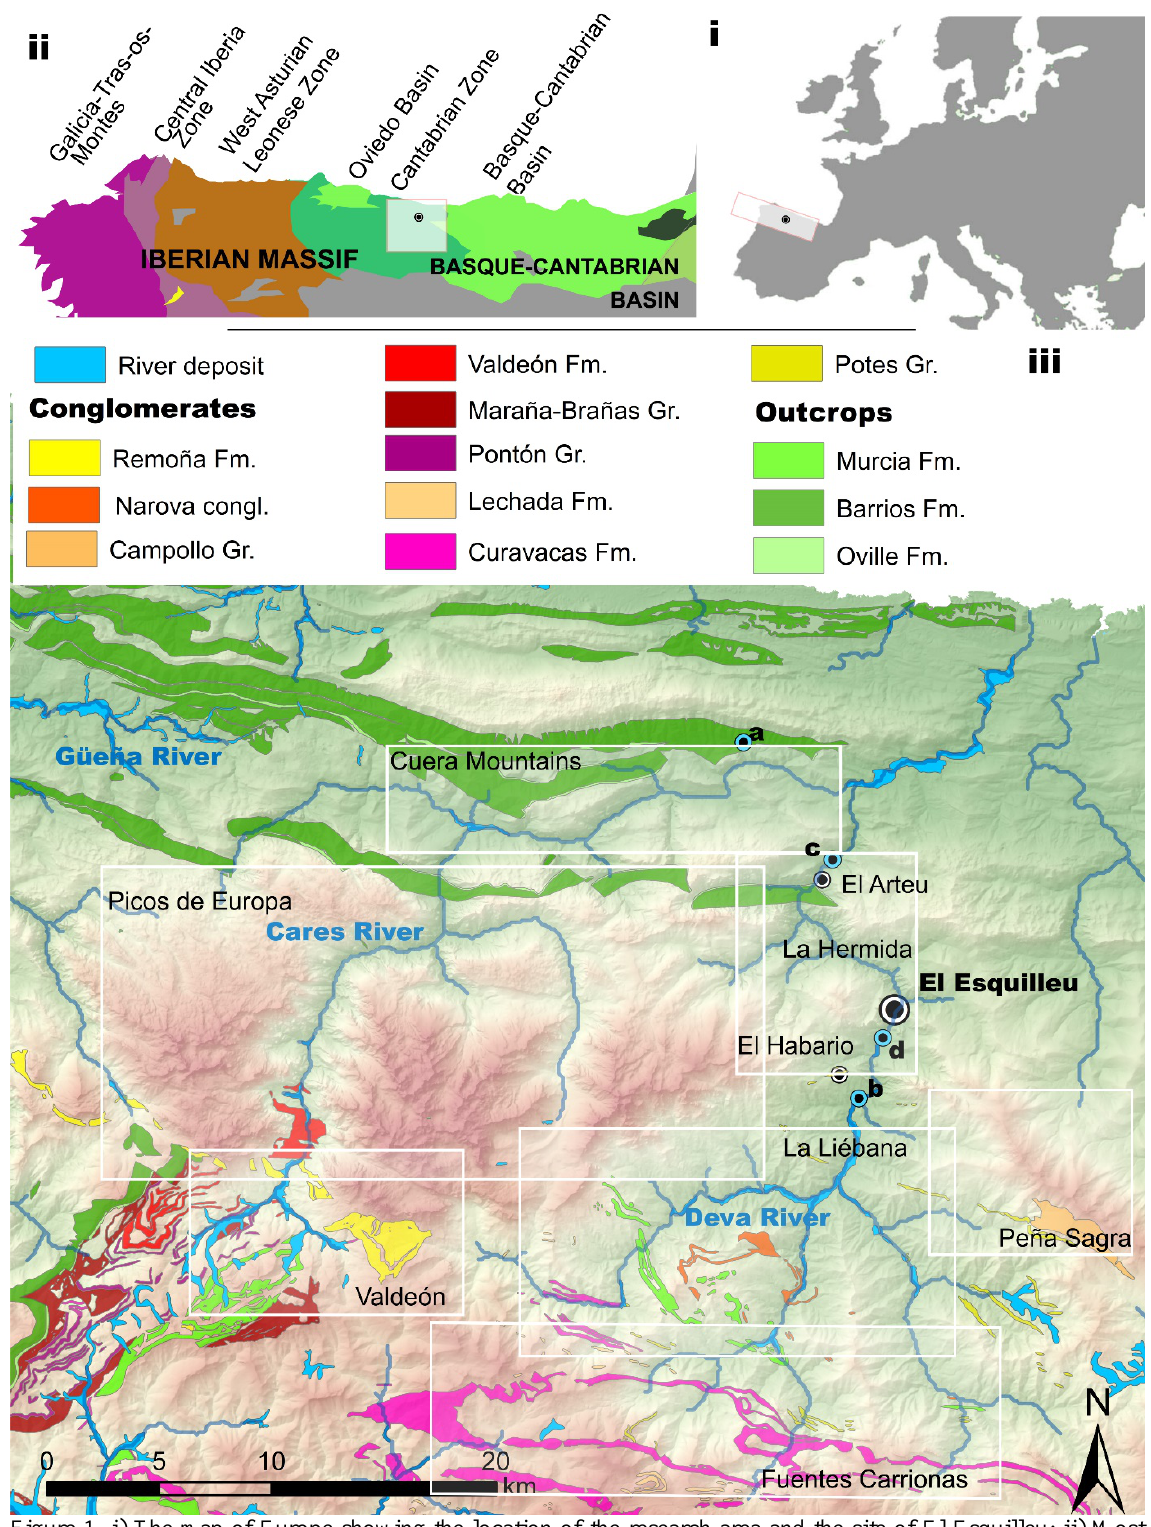
Figure 1. i) The map of Europe showing the location of the research area and the site of El Esquilleu; ii) Most relevant ii) general overview of the north of Spain displaying the main geological zones based on the 1:1,000,000 geological map (Álvaro et al . 1994). iii) Geologic map and colour legend representing the research area, the site of El Esquilleu and the other two sites mentioned in the discussion. The geological formations discussed on text (see references therein) are detailed, also river deposits in blue and the location of some sampling sites (a, b, c, d in Figure 4). Main rivers are expressed, also the most relevant zones discussed in the